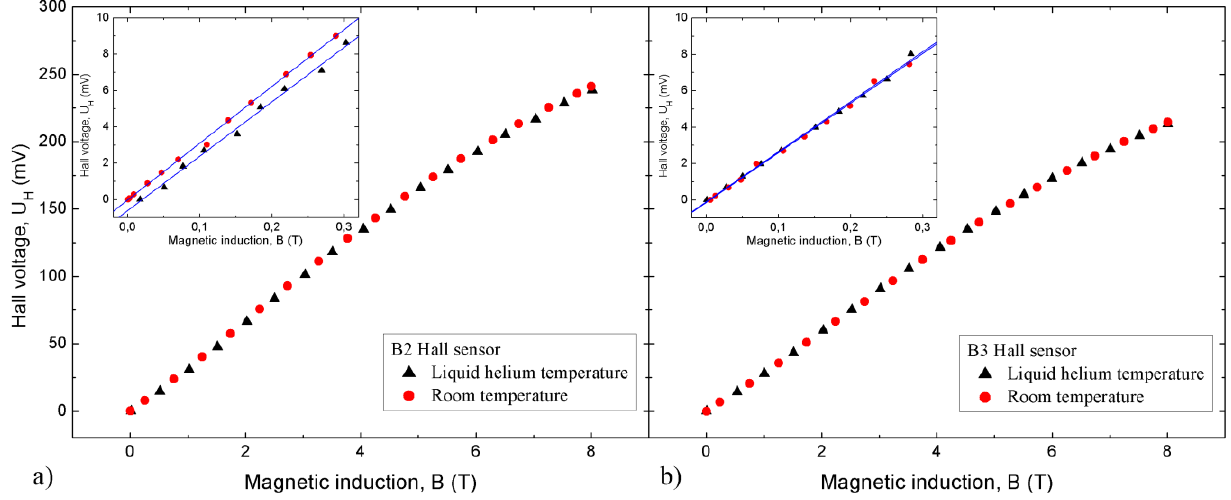
Figure 4. Field dependence of Hall voltage U sensors B2 and B3. This d0ependence at low magnetic fields is given in